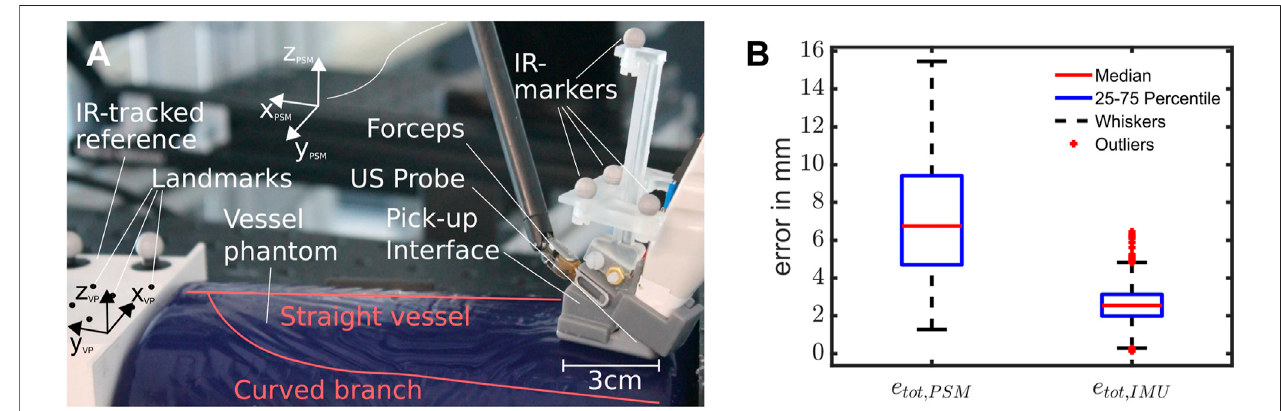
FIGURE6|(A) Setupfortheexperiments,witharoughlyoverlayedoutlineofthevesselstructureinsidethephantom,theultrasoundpick-upprobewithintegrated IMU and FSR and the reference block. (B) Box Plot showing the error distributions of the resulting scans using pure PSM- or IMU-based kinematics. Outliers are considered to be values outside the 1.5-fold interquartile range from each side of the box, demarked by whiskers ( n = 12,596 data points from ten scans).